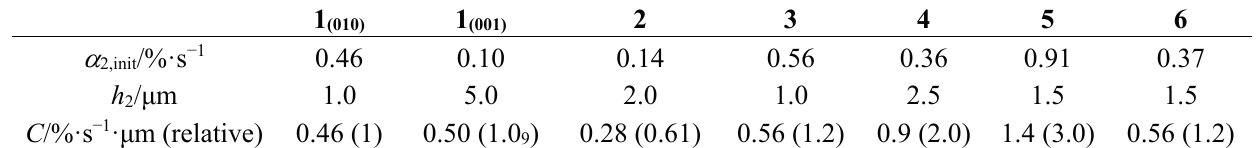
Table 1. Values of α 2,init , h 2 , and C for diarylethenes 1 – 6